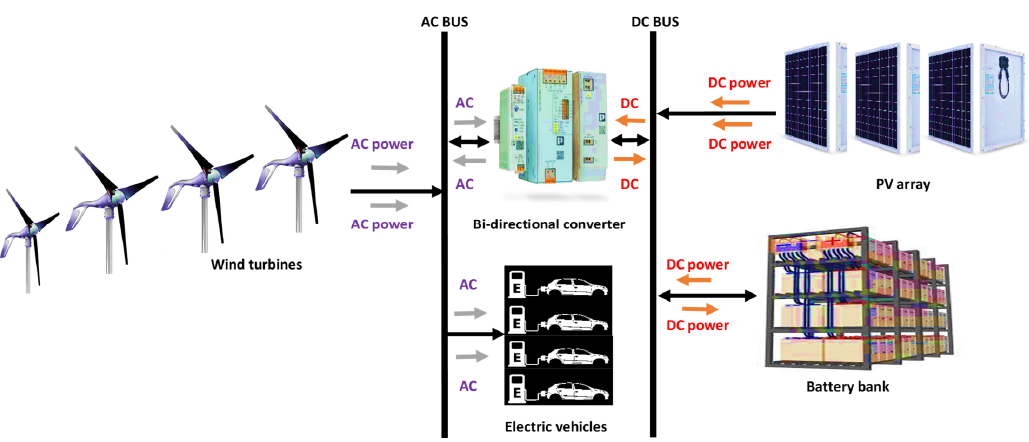
Figure 3. The energy flow schematic diagram of the suggested hybrid RE-based charging stations.